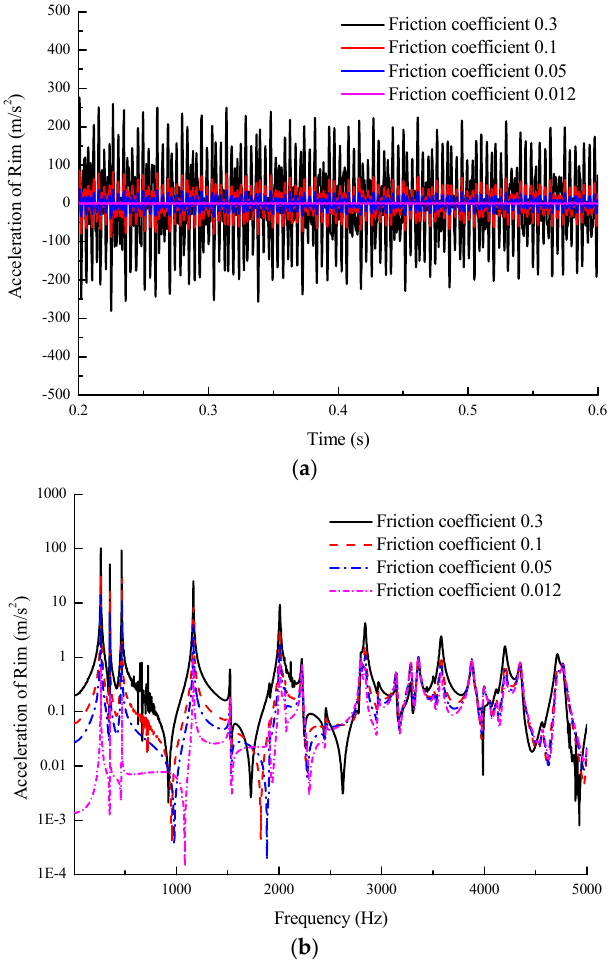
Figure 13. Accelerations with different friction coefficients in ( a ) time domain and ( b ) frequency domain (simulation results).